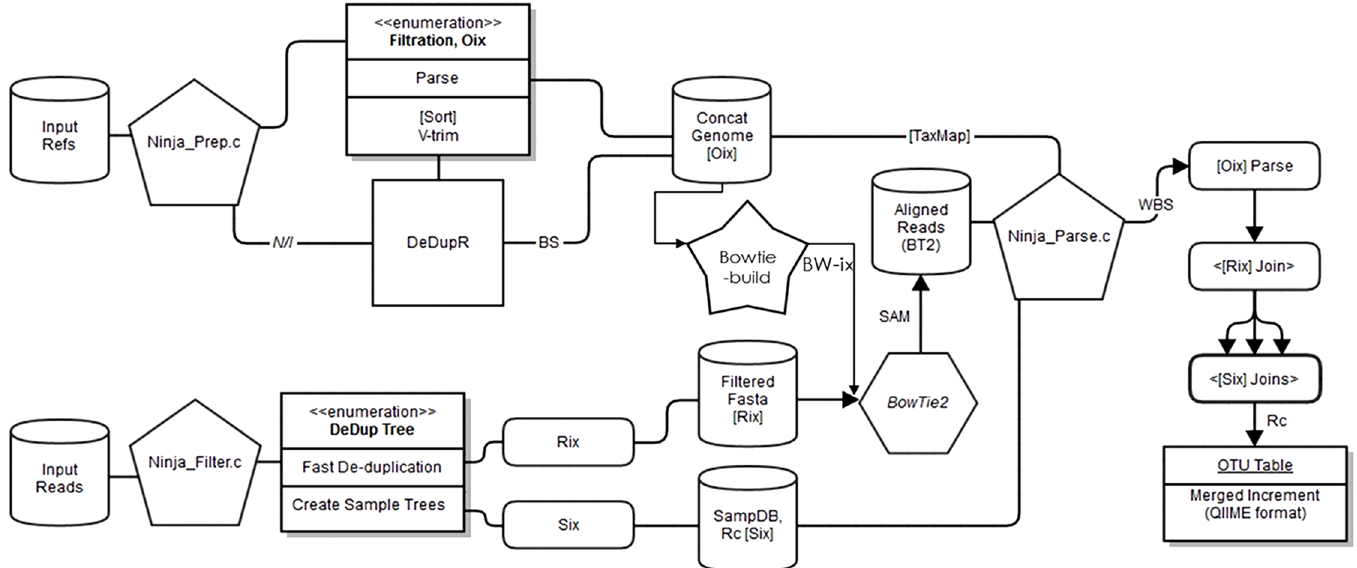
Fig 1. Schematic of the NINJA pipeline. NINJA core programs are represented by pentagons, data files by cylinders, processes within a program as lists, index operations as rounded rectangles, and other swappable programs by other shapes. The entire upper-left branch of the schematic (from input references to bowtie-build and TaxMap) does not need to be performed if using an existing database, such as that supplied with NINJA. The python wrapper encompasses the remaining two branches (bottom and right) for convenience. In general, Ninja_prep prepares the concatesome, Ninja_filter prepares the reads for alignment, bowtie2 (or any BWT-enabled aligner) performs the alignment, and Ninja_parse merges the various pieces into a complete OTU table.